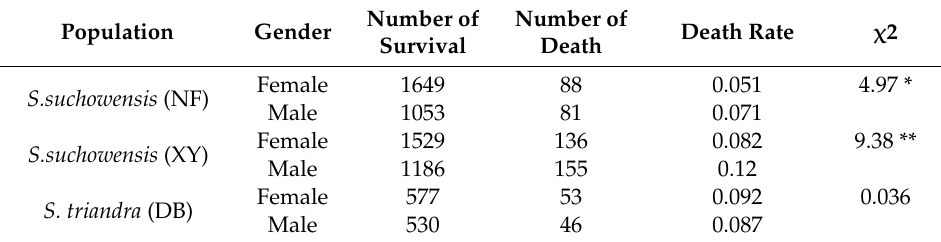
Table 3. Mortality statistics of willow